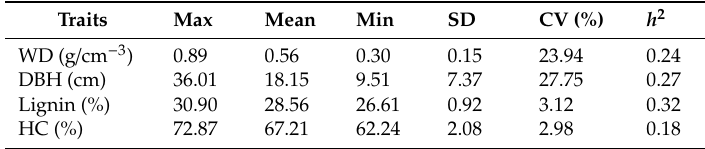
Table 1. Descriptive statistics of slash pine wood properties and DBH of 24-year-old P. elliottii .